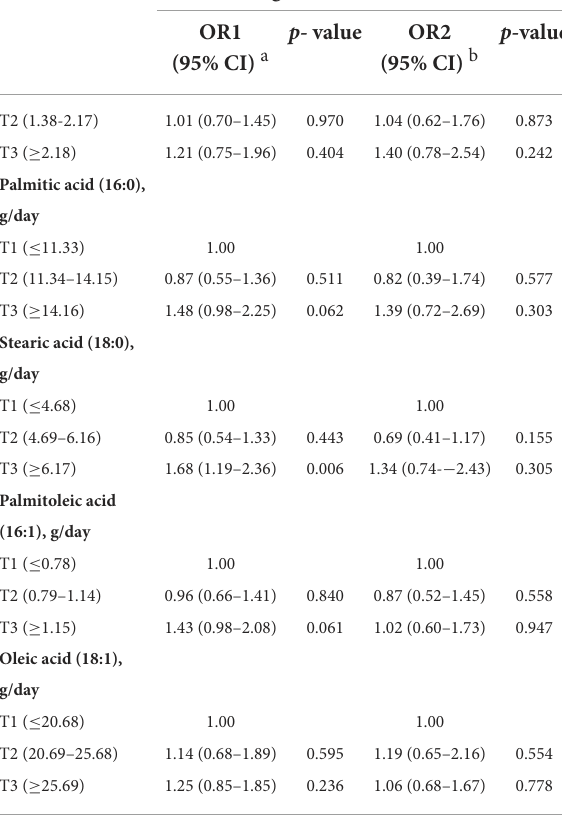
TABLE 3 Odds ratios (ORs) and 95% confidence intervals (CIs) for risk of significant liver fibrosis based on tertiles of dietary intakes of fatty acid